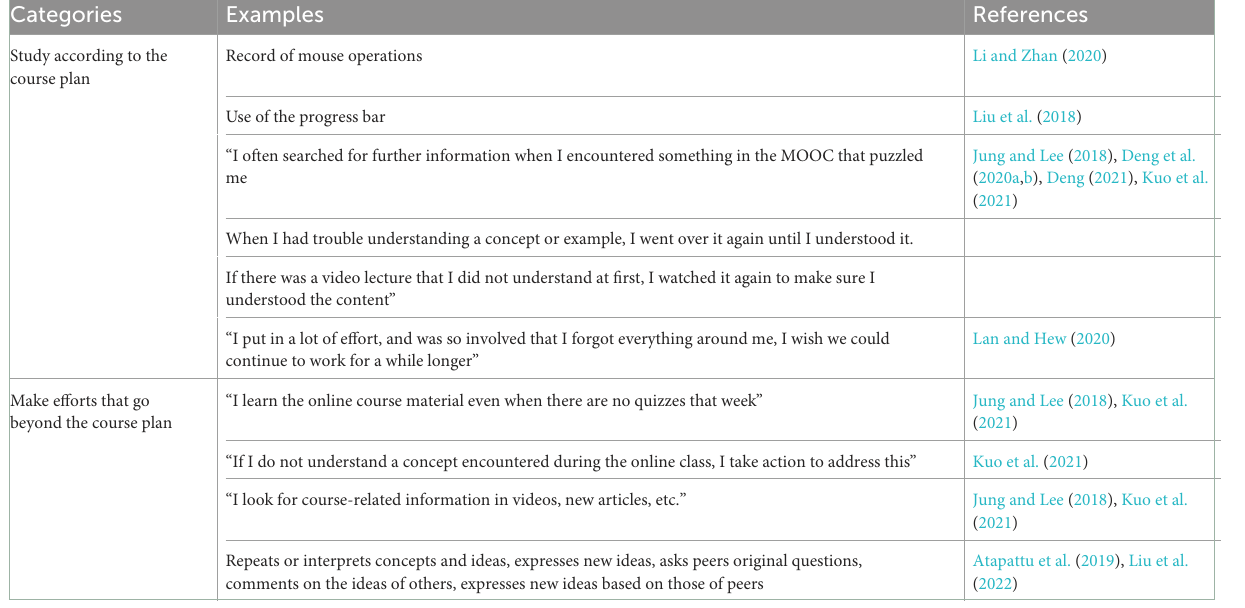
TABLE 5 Categories of cognitive engagement.